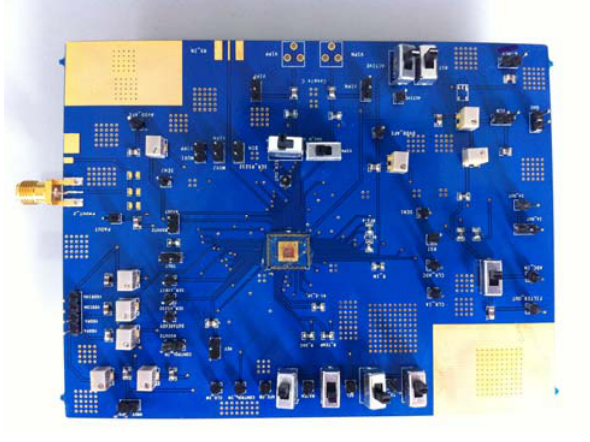
Figure 5. The picture of testing board module including the SSoC at the center.